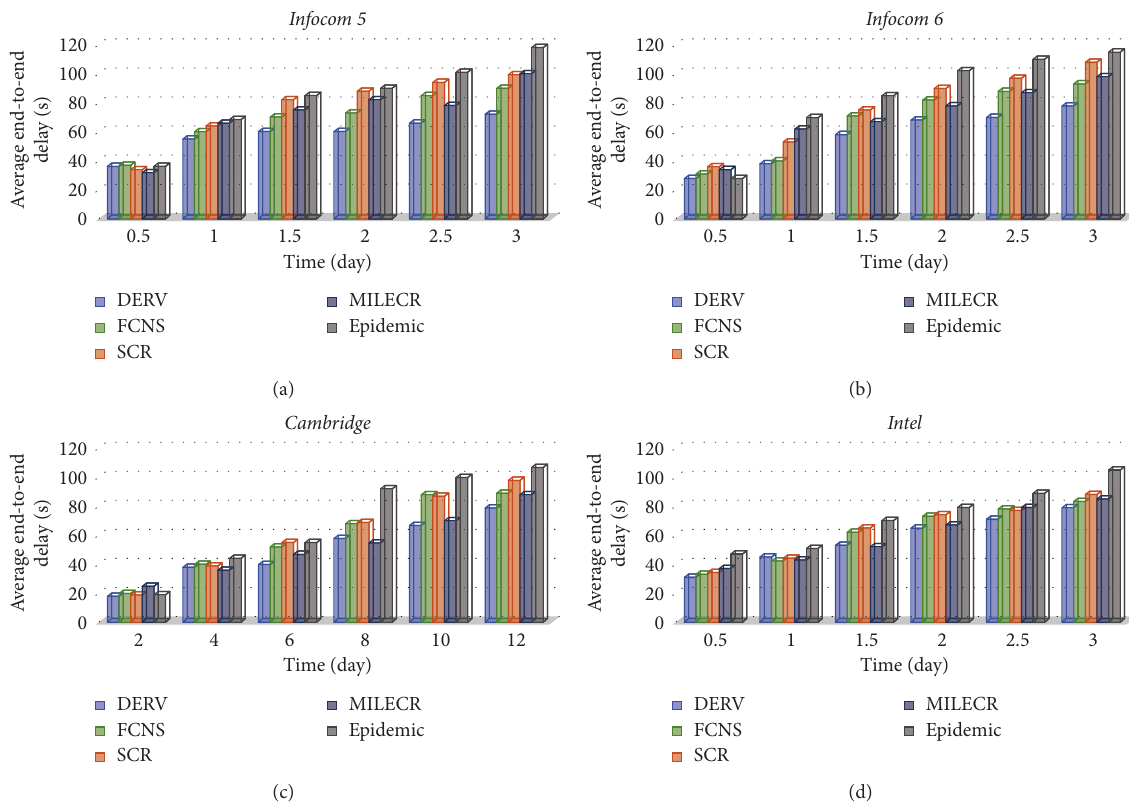
Figure 4: (a–d) The average end-to-end delay for the DERV, FCNS, SCR, MILECR, and epidemic algorithms on datasets Infocom5, Infocom6, Cambridge,